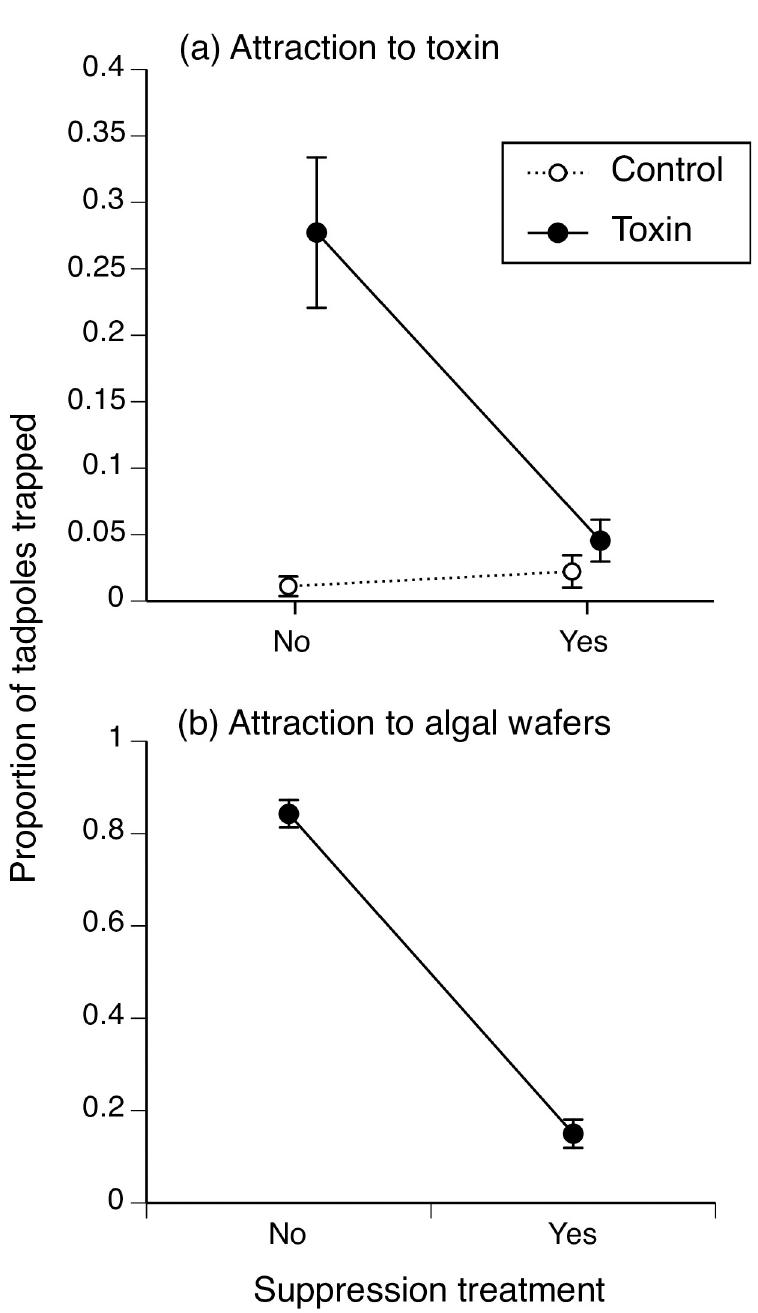
Fig 1. The proportion of non-suppressed and suppressed cane toad tadpoles ( Rhinella marina ) captured in funnel traps after 90 min, when traps were baited with (a) 200 mg of adult toad toxin or unchlorinated bore water (n = 9–11), or (b) 200 mg of algal wafer (n = 7). Suppression-treated tadpoles were exposed to older conspecifics for 48 h during larval development. The graphs show mean values ± SE.